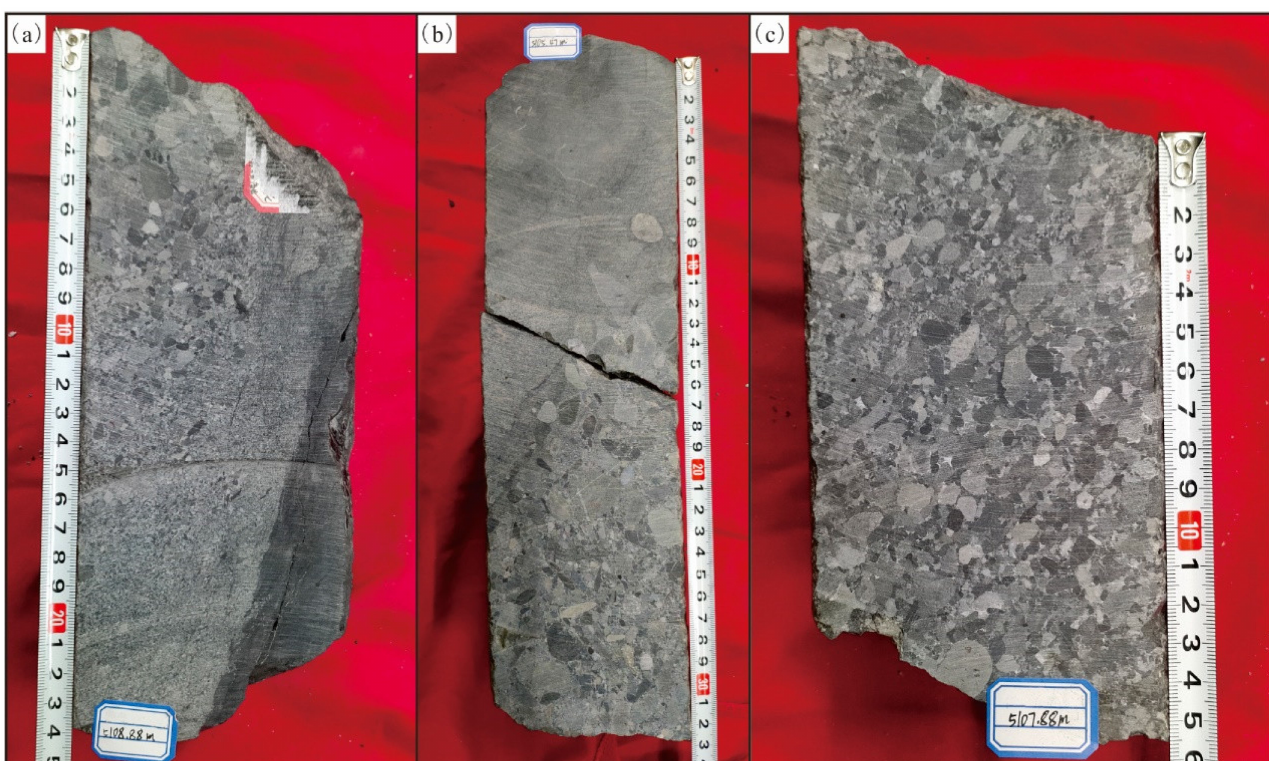
Figure 4. Seismic grain-supported conglomerate in the Carboniferous formation of the Shibei sag. ( a ) Well ZB6: well depth 5108.88 m, inverse progressive beddings; ( b ) Well ZB6: well depth 5105.47 m, inverse progressive beddings; ( c ) Well ZB6: well depth 5107.88 m, inverse-positive progressive